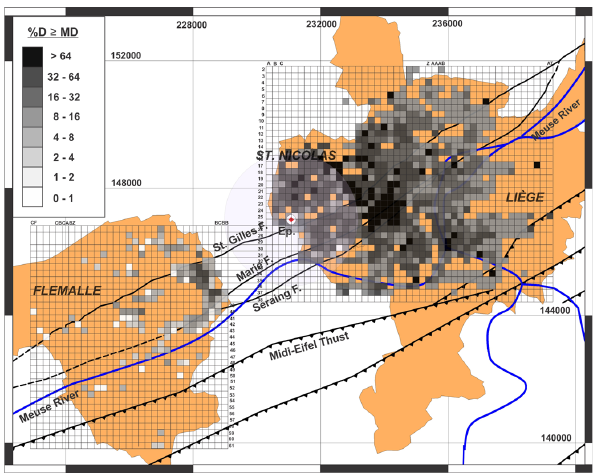
Fig. 8. MRSA (period ∼ 0.3s) distribution during the 1983 Li`ege earthquake estimated from the HAZUS fragility curve for square areas of 0.040km 2 over the localities of Saint Nicolas, Li`ege and Fl´emalle. Projections: Belgian Lambert